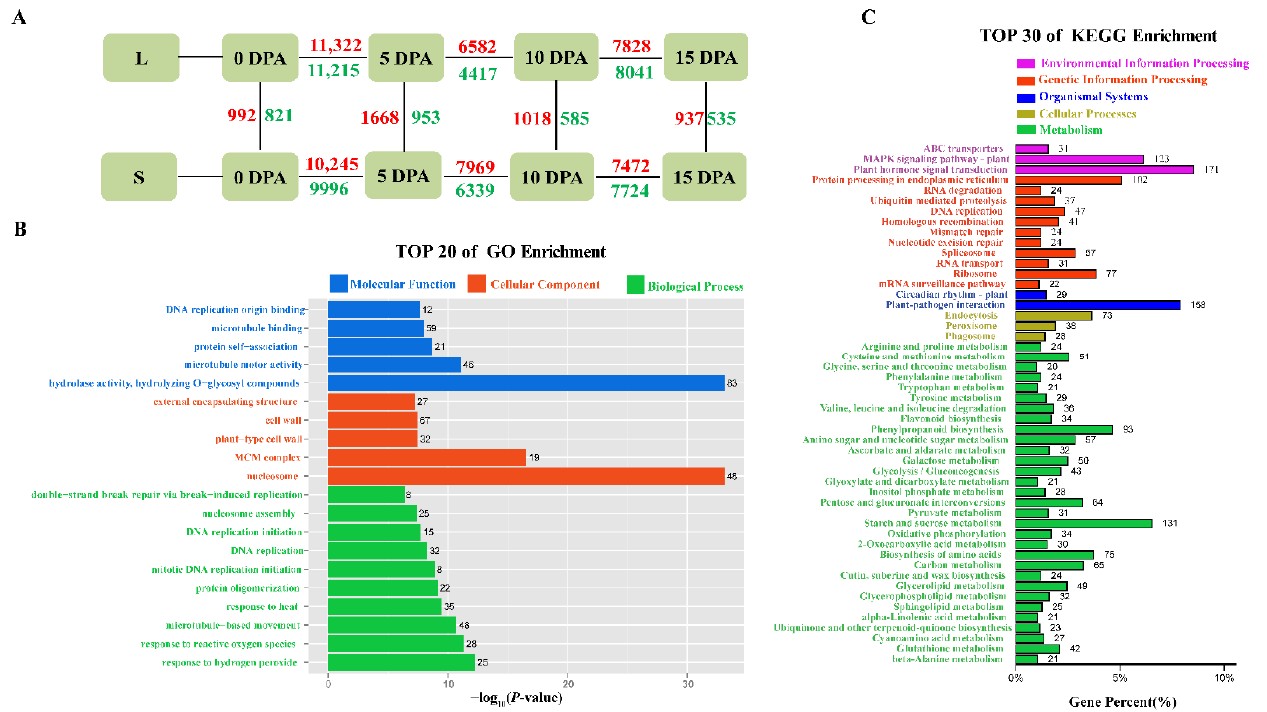
Figure 3. Statistical and enrichment analysis of DEGs. ( A ) Multiple comparisons of L and S in fiber development. Numbers indicate the number of DEGs. Red, upregulated; green, downregulated. ( B ) GO-term enrichment analysis of 6055 genes. ( C ) KEGG enrichment analysis of 6055 genes.